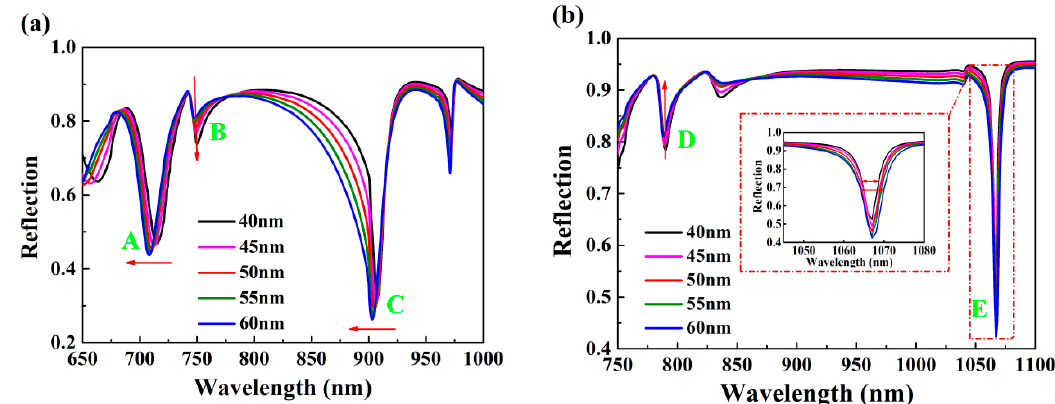
Figure 4. The effect of different nanowell width w on resonant dips under incident angle ( a ) 65° and Figure 4. The e ff ect of di ff erent nanowell width w on resonant dips under incident angle ( a ) 65 ◦ and ( b ) ( b ) 30°. Inset in ( b ) clearly shows the change of line width of dip E for different nanowell width w . 30 ◦ . Inset in ( b ) clearly shows the change of line width of dip E for di ff erent nanowell width w